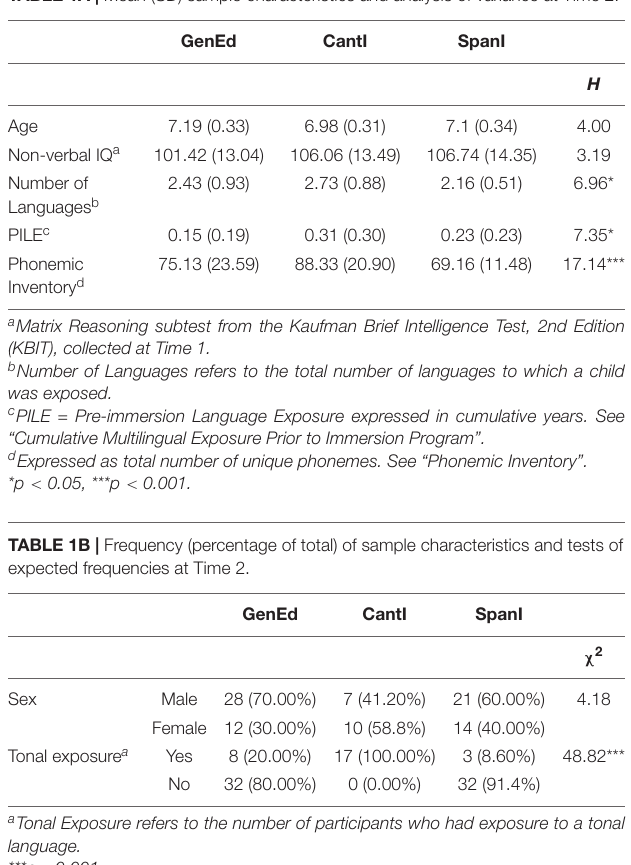
TABLE 1A | Mean (SD) sample characteristics and analysis of variance at Time 2.